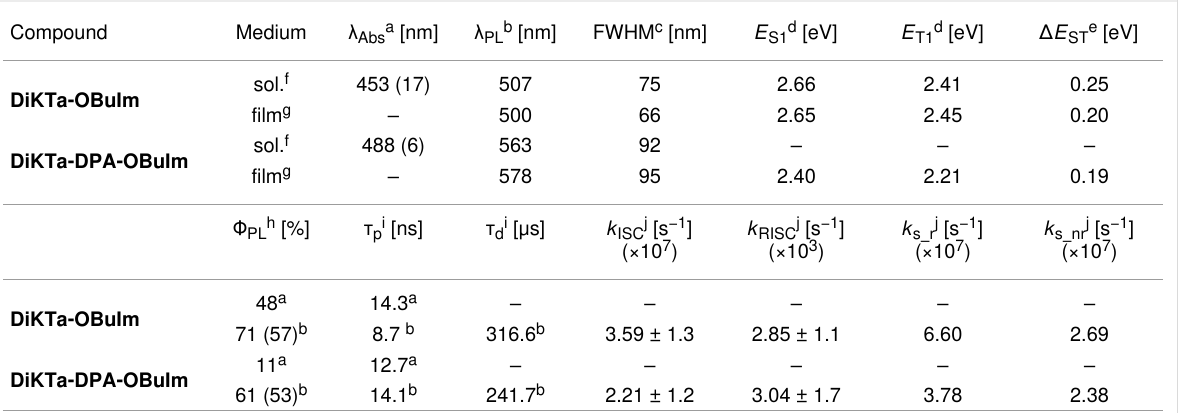
Table 1: Photophysical properties of DiKTa-OBuIm and DiKTa-DPA-OBuIm . Compound